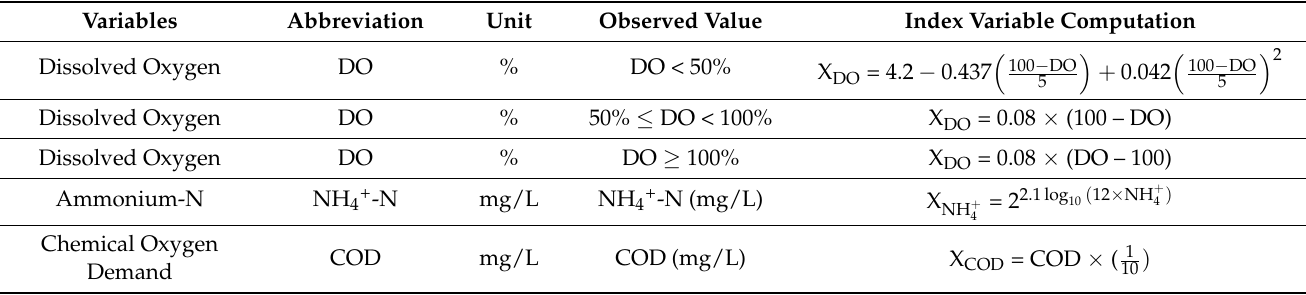
Table 3. Variables, units, and formulas to compute Prati indices [14].